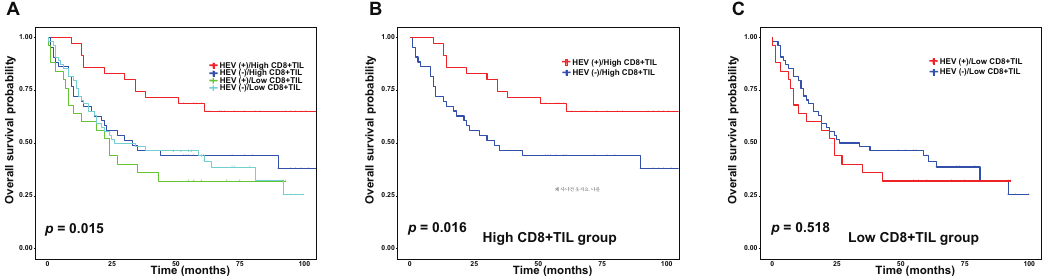
Figure 4. Prognostic e ff ects for combined analysis of CD8 + TILs and HEVs. ( A ) Patients with a high CD8 + TIL density and HEVs demonstrated a longer OS than patients with a non-high CD8 + TIL density and HEVs ( p = 0.015). ( B ) In patients with a high CD8 + TIL density, those with HEVs showed a favorable OS ( p = 0.016). ( C ) An OS di ff erence was not observed between patients with / without HEVs in the low CD8 + TIL level group ( p =